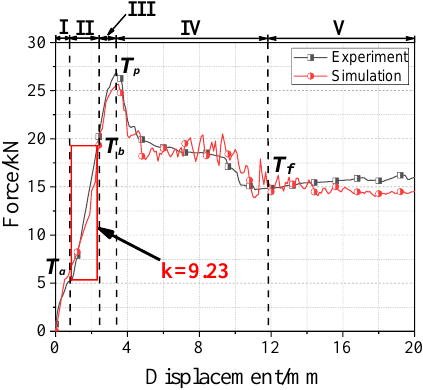
Figure 9. Shear–displacement comparison curves of the experiment and simulation. ( T a is the start of the elastic phase, T b is the yield point of the wellbore, T p is the peak point of the shear stress and T f is the end of the strain-softening phase.)